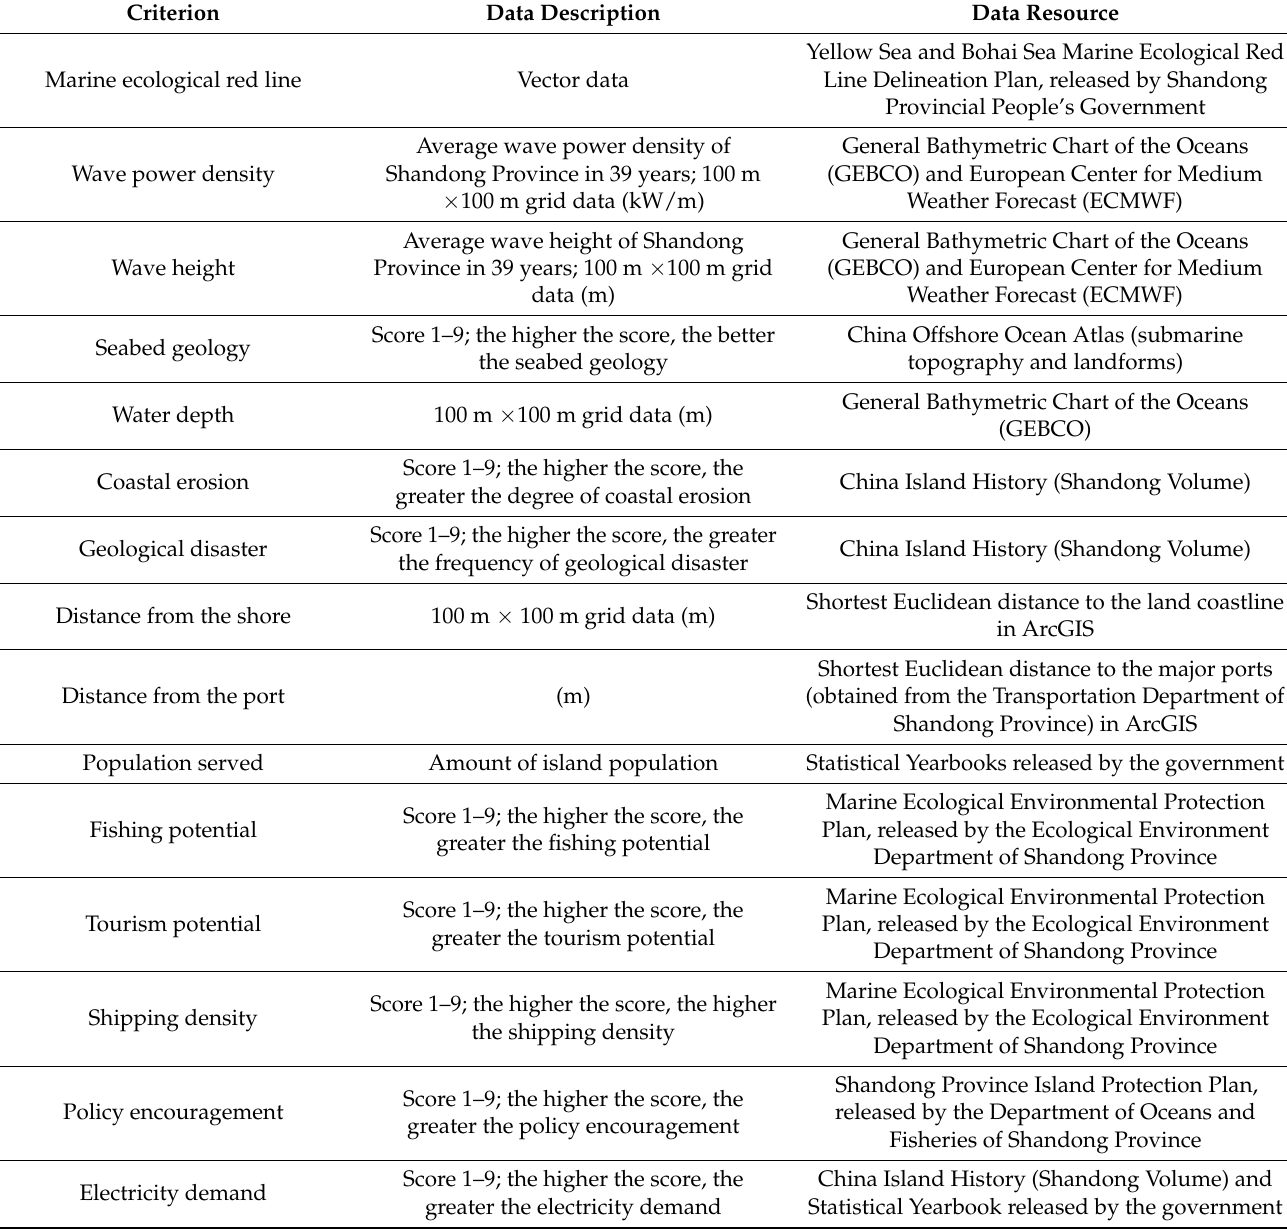
Table 2. Data descriptions and sources of